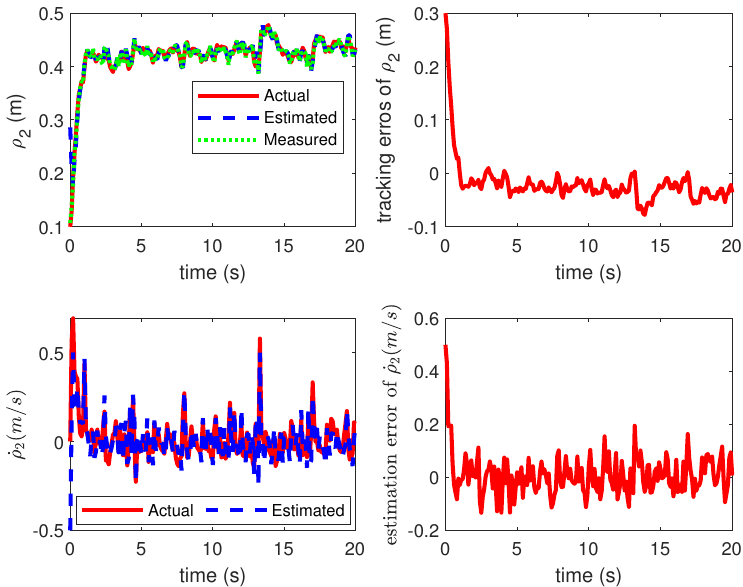
Figure 13. Case 3: state variables ρ 2 , ˙ ρ 2 and their tracking/estimation errors.